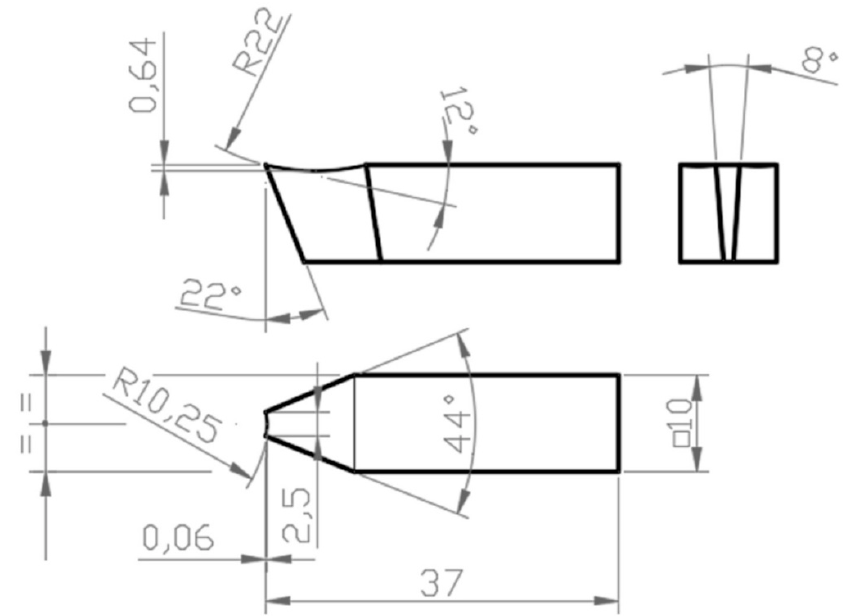
Figure 7. Geometric and constructive elements of the radial slotting tool and holder bar for cutting tool [3,15].